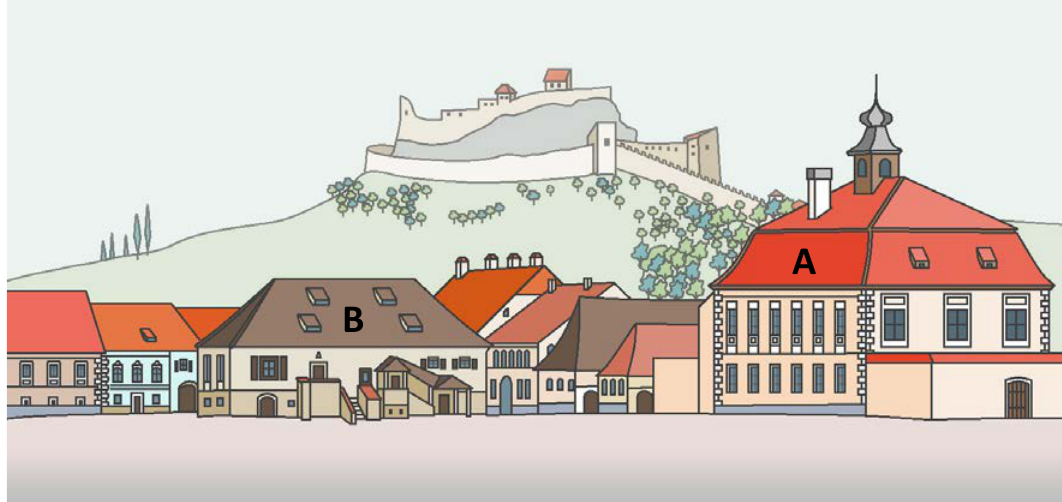
Figure 4: Redrawing the Lithograph on Reps by G. Pearson (published in Boner, 1865, p. 244) Drawing by Zoltan MAROȘI,